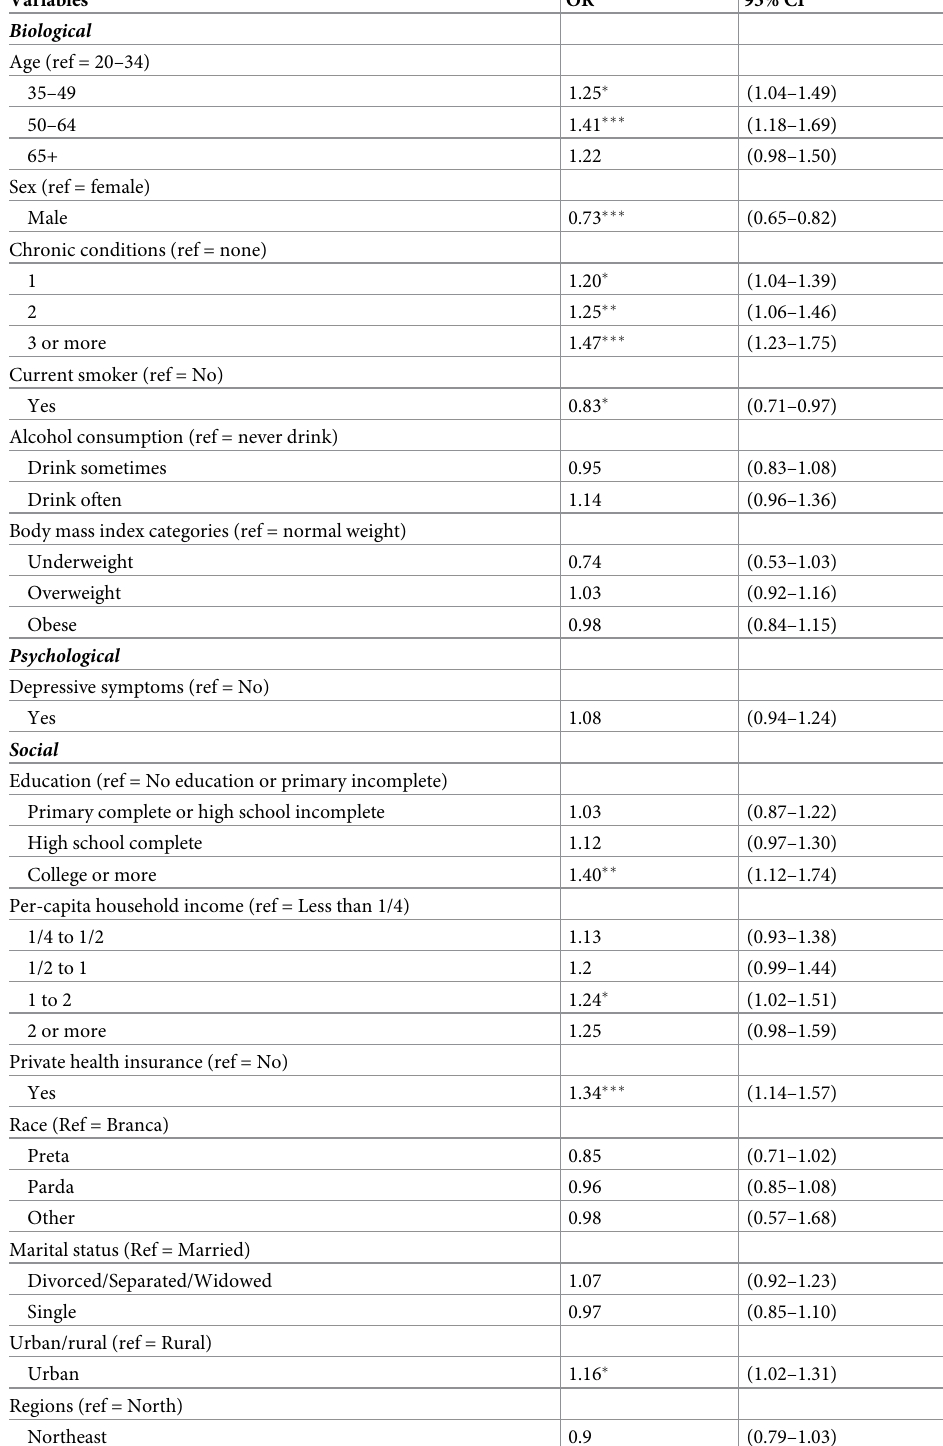
Table 5. Adjusted odds-ratios and 95% confidence intervals on the associations between getting treatment for pain and biopsychosocial